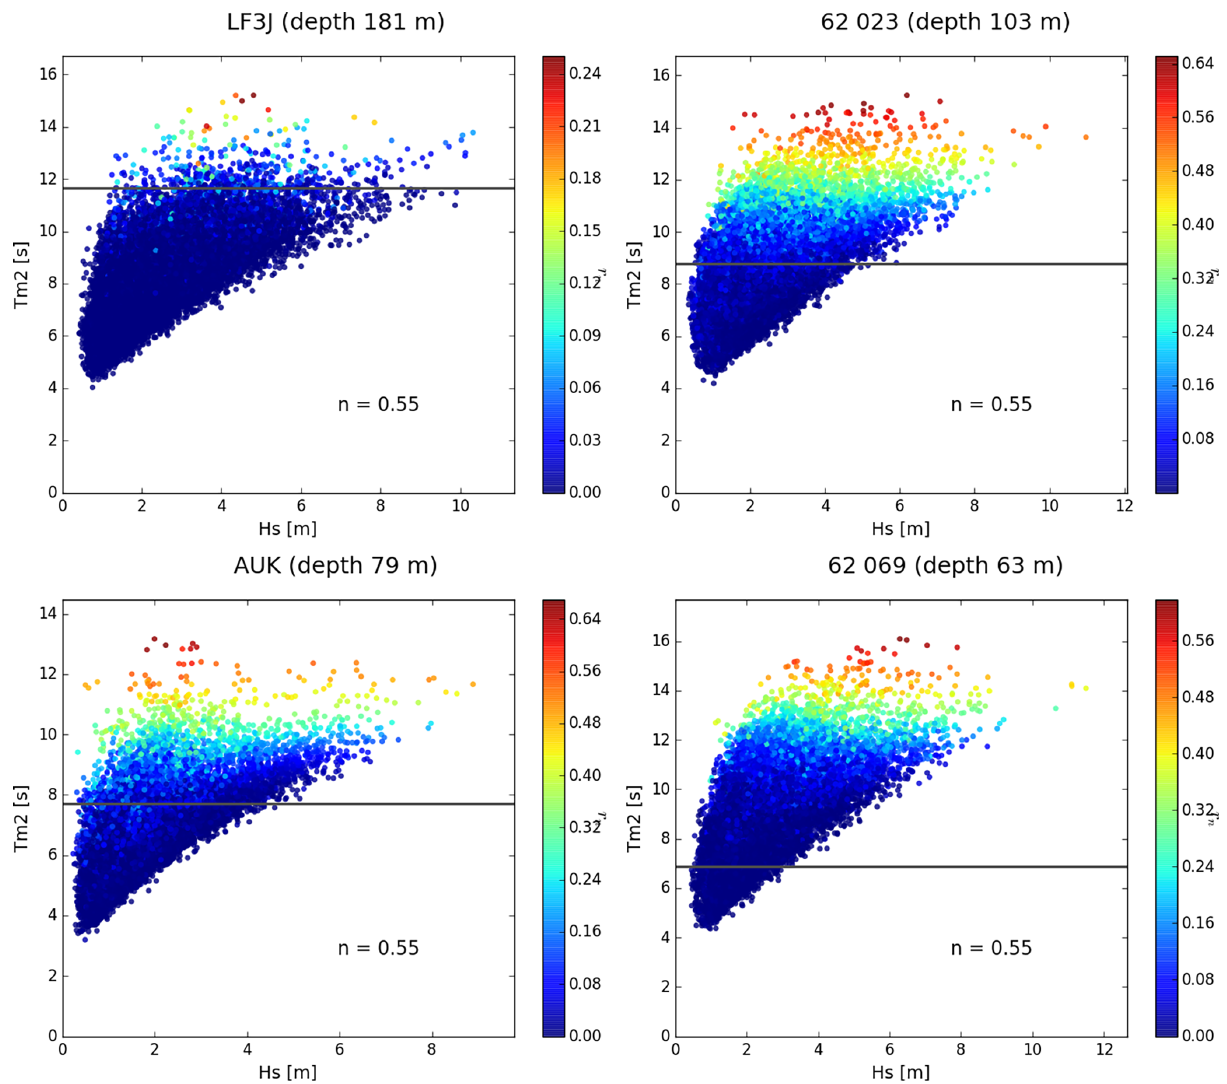
Figure 5. Scatter plot of all the data points for stations LF3J, 62023, AUK, and 62069, with colors indicating r 0 . 55 values. The gray line indicates the period corresponding to n = 0.55 for each